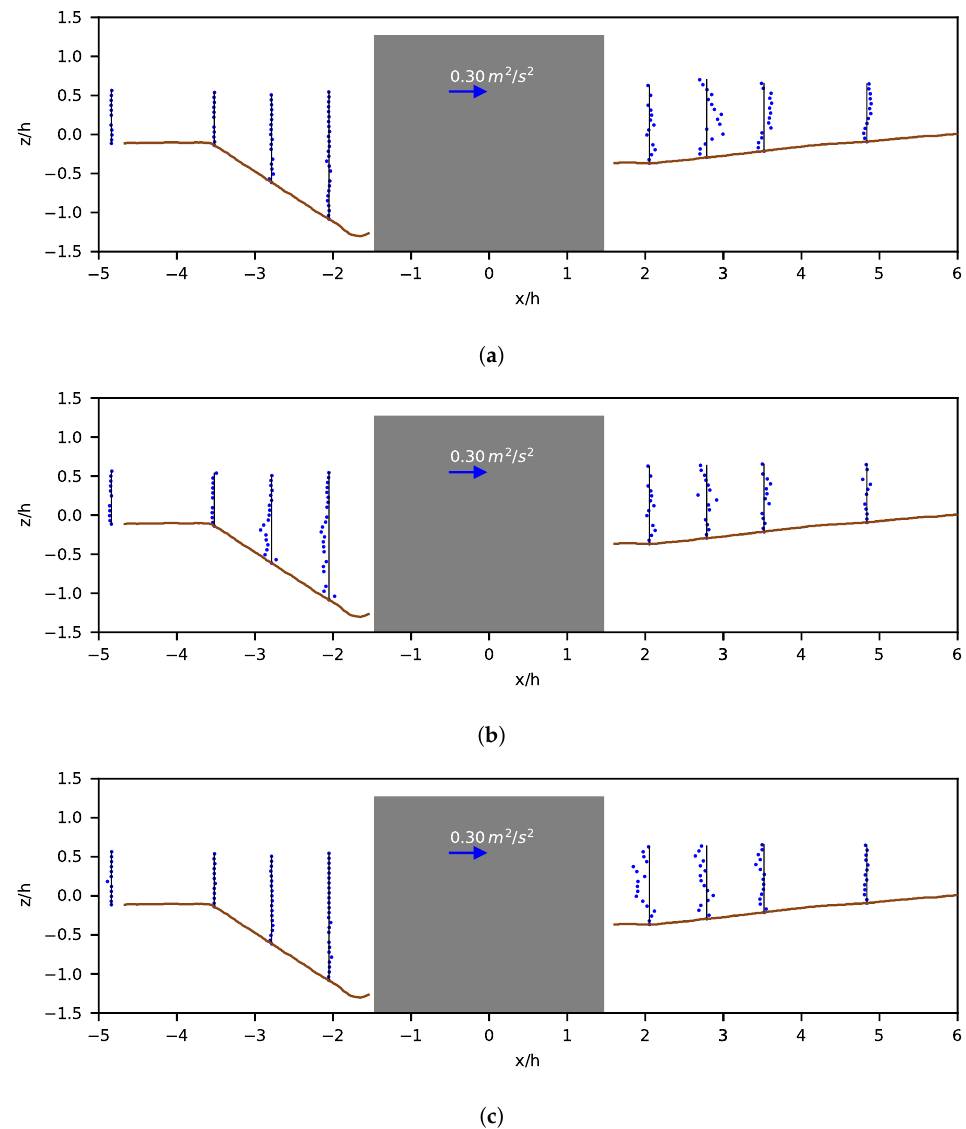
Figure 17. Vertical profiles of the Reynolds shear stresses along the pier’s mid-plane for Exp . 1 D Ebed . ( a ) Reynolds shear stresses ( u (cid:48) v (cid:48) ). ( b ) Reynolds shear stresses ( u (cid:48) w (cid:48) ). ( c ) Reynolds shear stresses ( v (cid:48) w (cid:48)